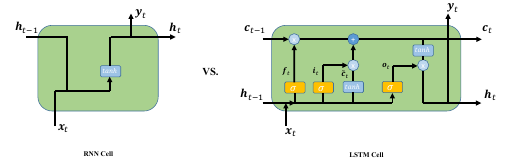
Figure 7. Structure of an RNN Cell and an LSTM Cell noting the differences between the two.